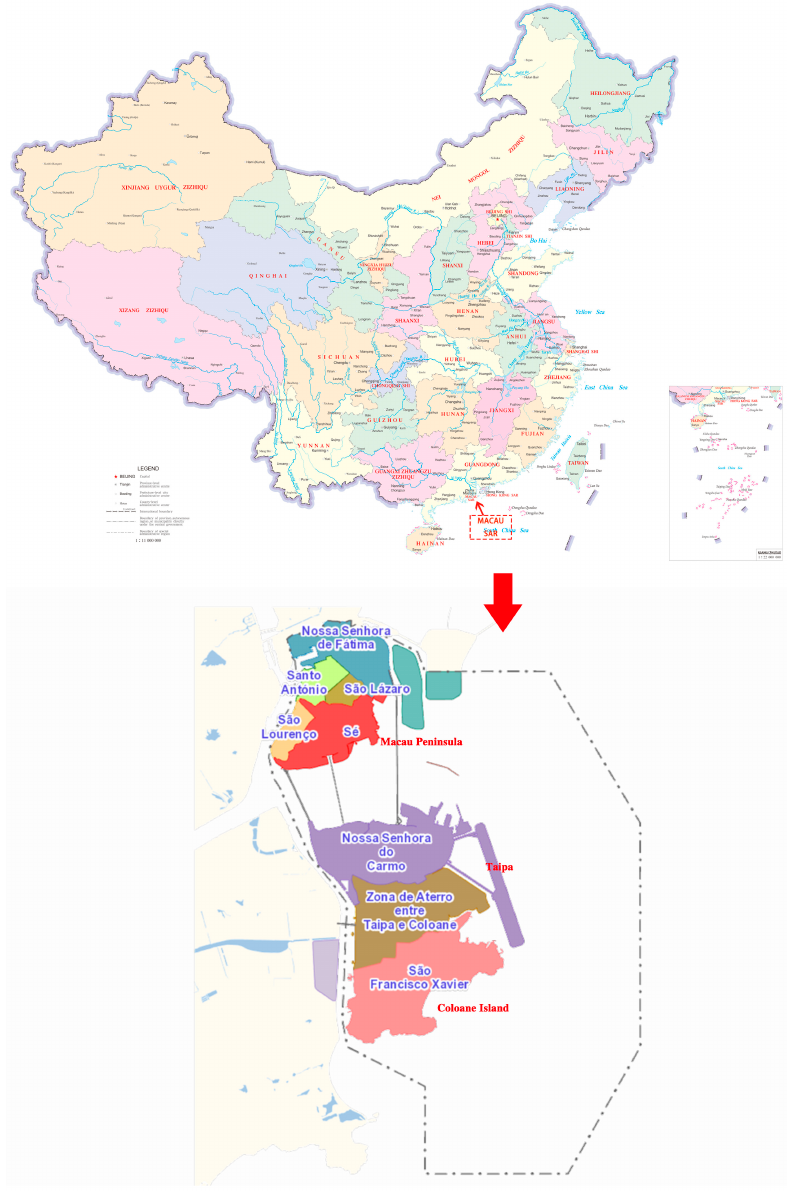
Figure 1. Macau Location Map.